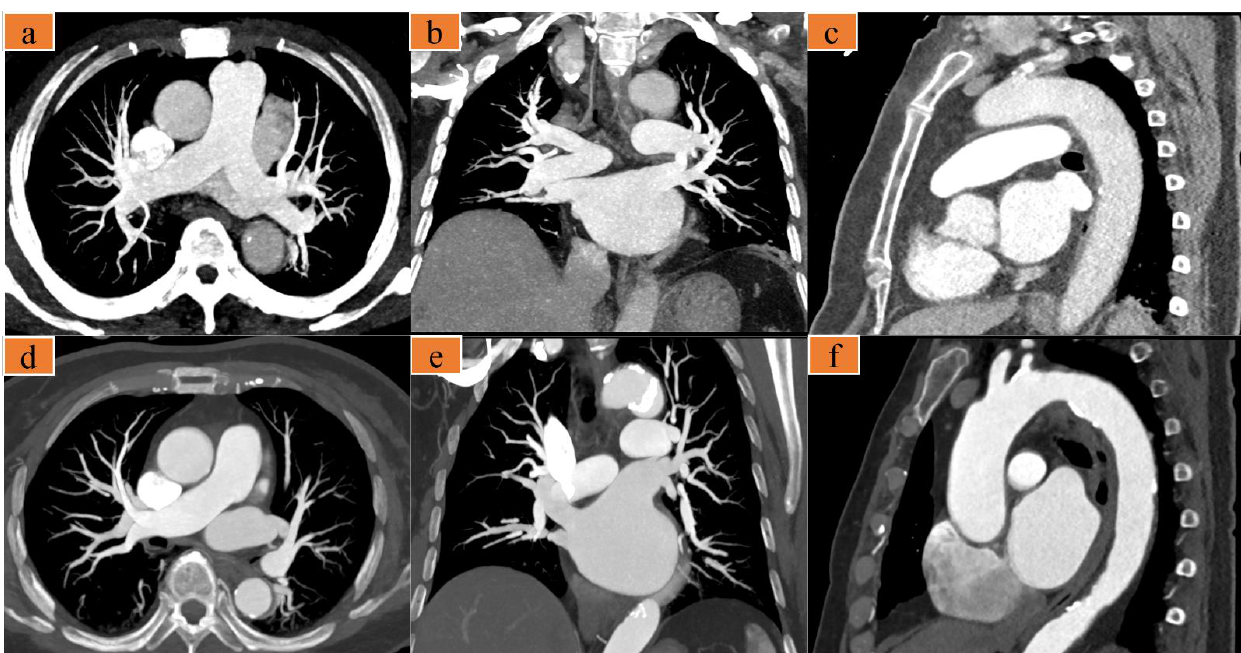
Figure 3. ( a – c ) A 75-year-old woman with chest pain, heart rate 77 bpm. Images were acquired with the optimized scanning scheme. ( d – f ) A 67-year-old woman presents to the emergency room with several days of chest pain, heart rate 66 bpm. Images were acquired with the traditional triple-rule-out computed tomography angiography (TRO-CTA). ( a ) and ( d ) are axial maximum intensity projection (MIP) images showing the pulmonary artery; ( b ) and ( e ) are coronal MIP images showing the pulmonary artery; and ( c ) and ( f ) are sagittal MIP images showing the thoracic aorta.